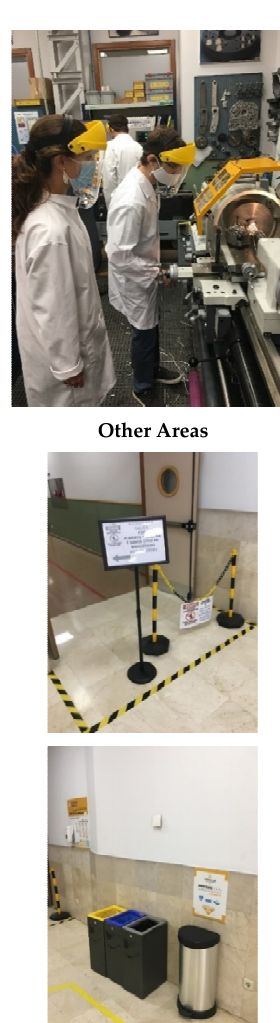
Figure 6. Visual comparison of entrances, classrooms, laboratories and other areas.